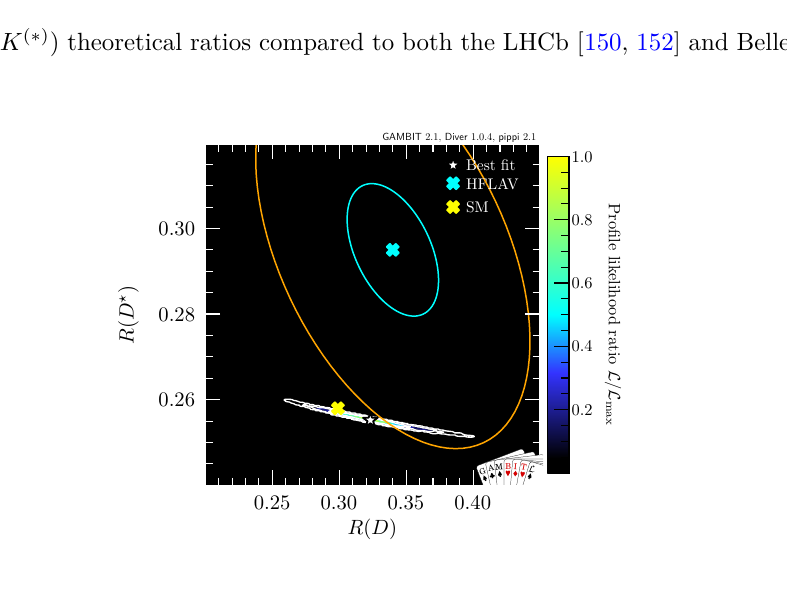
Figure 15 . R ( D ∗ ) versus R ( D ) correlated ratios. The cyan and orange lines are the 1 σ and 3 σ deviations from the HFLAV average